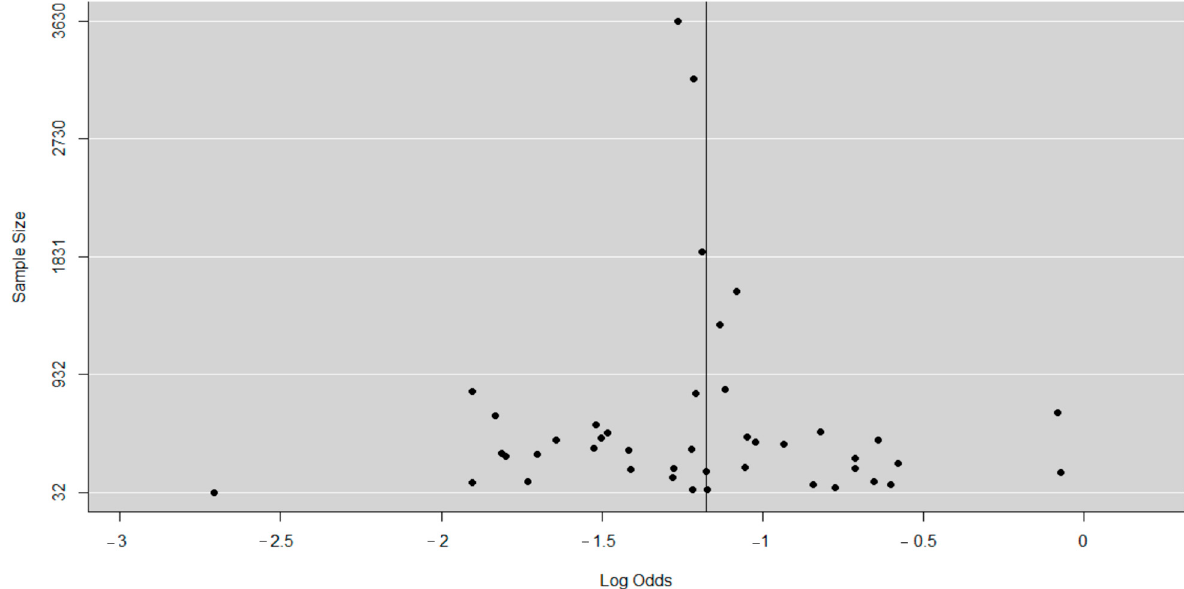
Viruses 2021 , 13 , x FOR PEER REVIEW Figure 4. Funnel plot showing the presence of publication bias. Figure 4. Funnel plot showing the presence of publication bias.